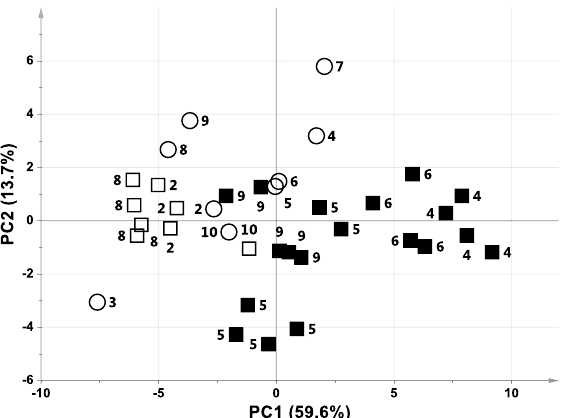
Figure 3. PCA score plot of ACA plasma samples collected at baseline vs. the pre-arrest samples from the 5th minute (A = 3, Par, R 2 = 0.83, Q 2 = 0.67). Samples are represented by open circles at baseline, black squares at pre- arrest for ND animals, and open squares at pre-arrest for D animals. Labels correspond to the animal